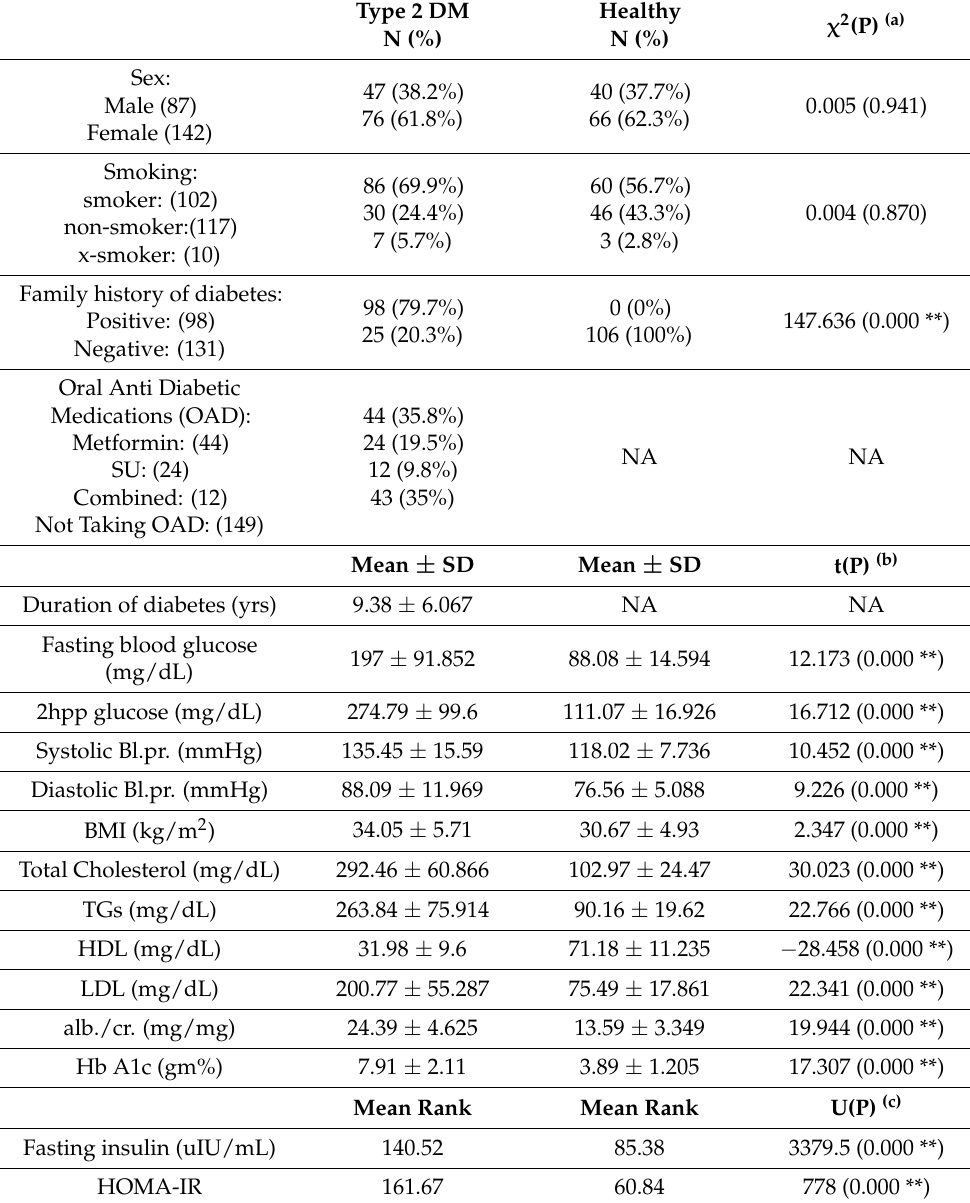
Table 1. Study demographic data between the diabetic and healthy groups ( n =